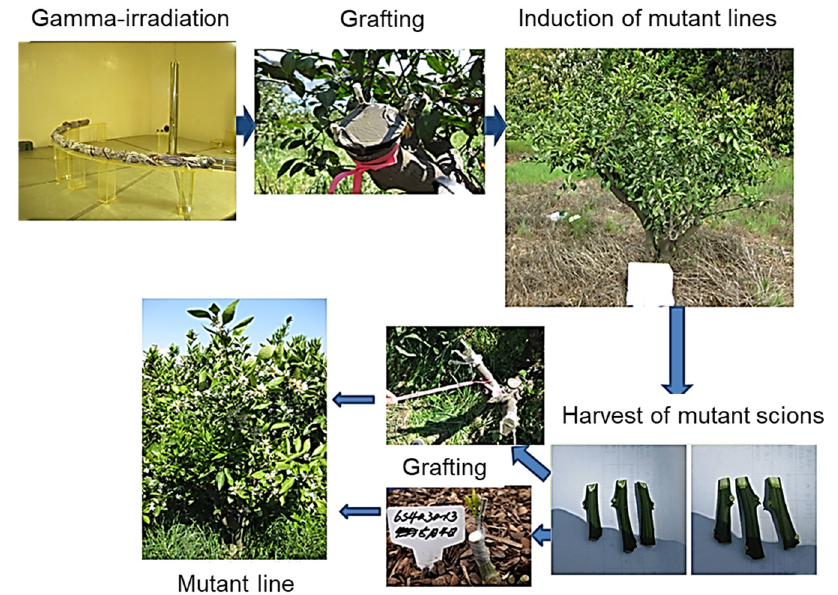
Figure 1. Mutagenesis by gamma irradiation of C. unshiu scions and the selection of mutant indi- viduals by grafting.